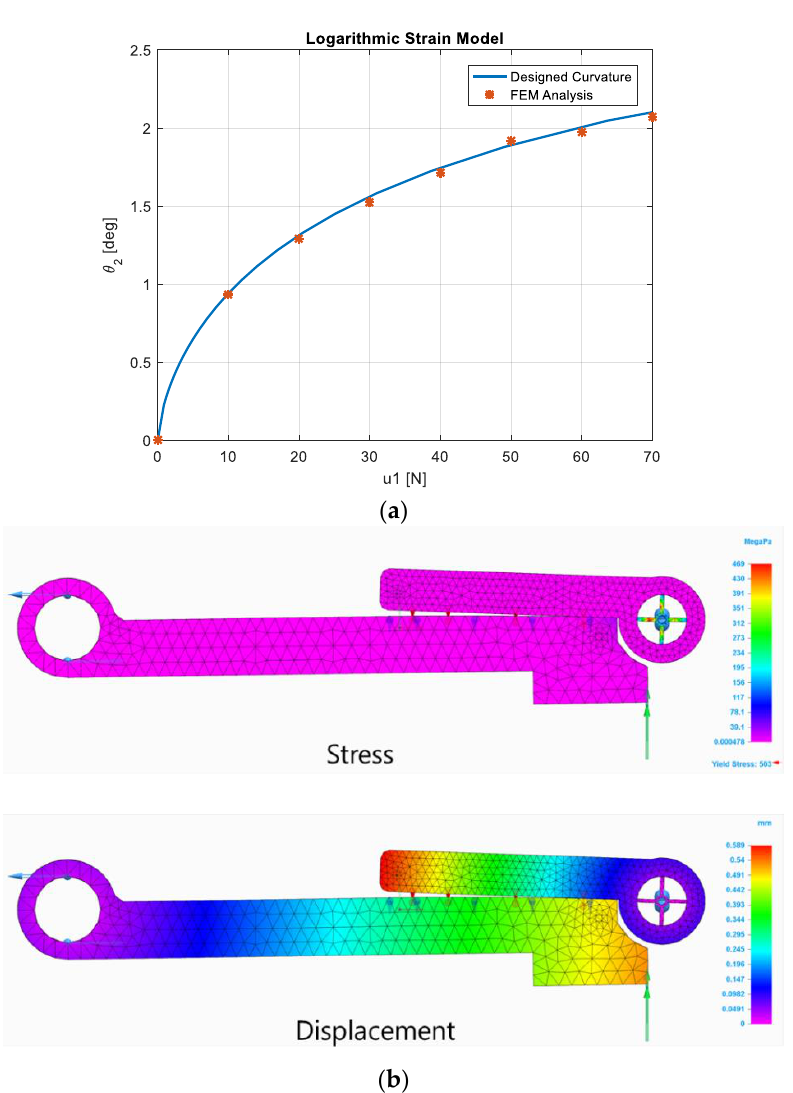
Figure 3. FEM Analysis. ( a ) Strain curvature. ( b ) FEM snapshot ( 𝑢 1 = 60 N ).